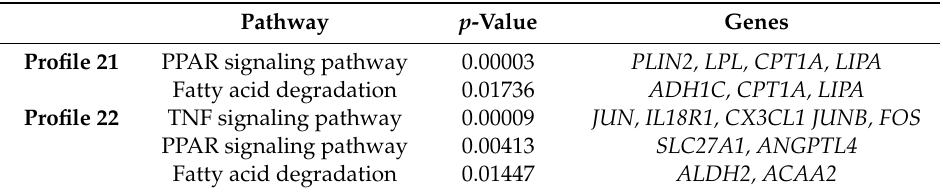
Table 6. Summary of KEGG enrichment analysis of DEG